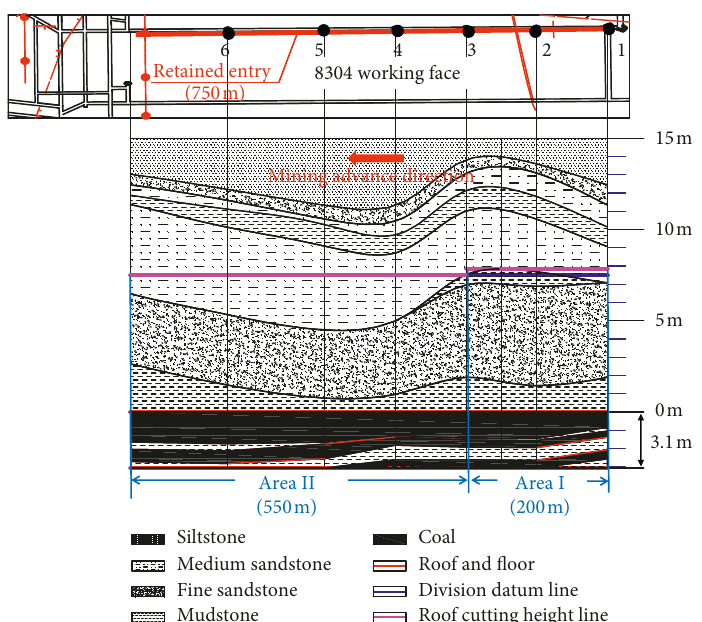
Figure 8: Roof lithology and division of the 8304 working face in Tashan Coal Mine: 1, 2, ... , 6 are the six roof lithologic peepholes located at footage 0m, 100m, 200m, 300m, 400m, and 550m of the working face, respectively.